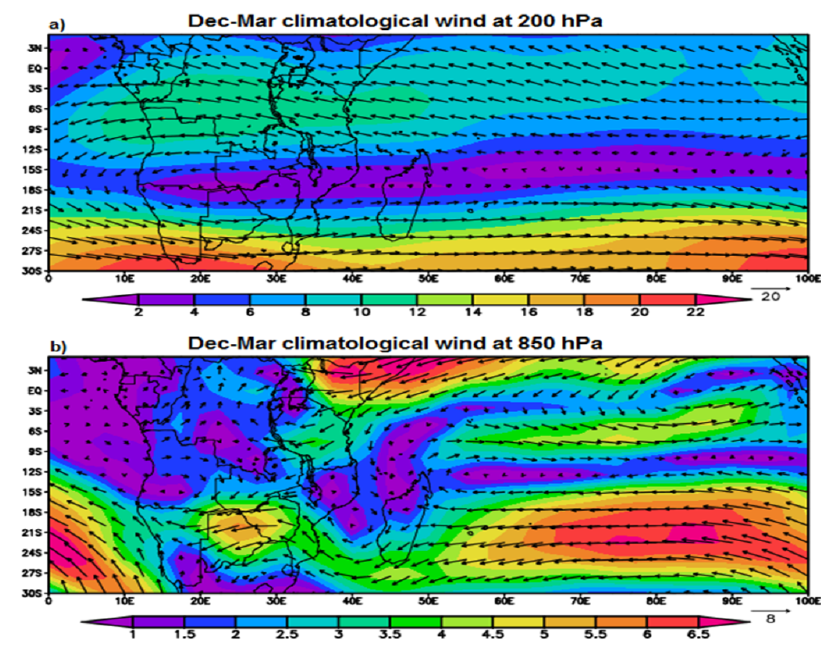
Figure 2. Mean (Dec–Mar 1979–2019) wind fields at 200 ( a ) and 850 hPa ( b ). Colors indicate the magnitude (m/s) and vectors the